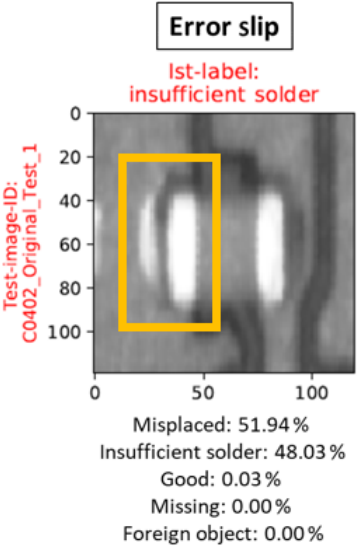
Figure 5. Error slip on C0402 of test dataset Te_A. Table 5. Error slip of the network on test dataset Te_A.